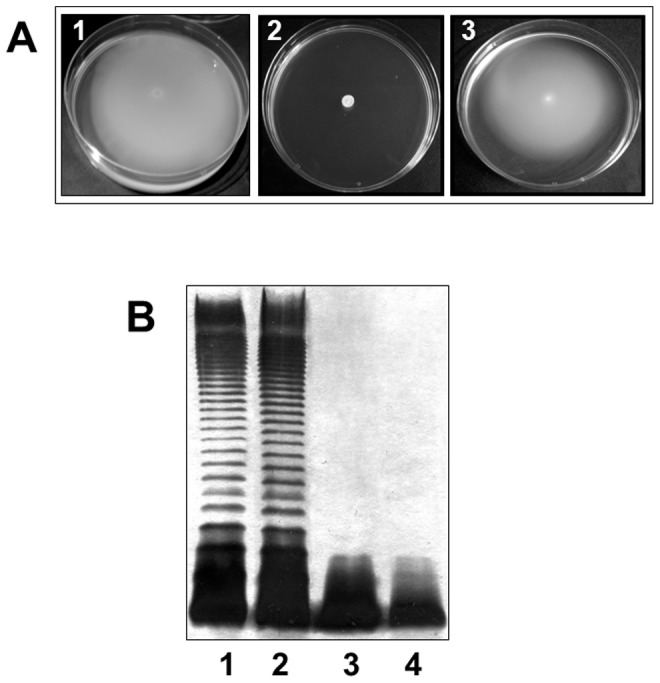
A/Motility phenotypes exhibited in swim (0.25%) agar by A. hydrophila AH-3 (1), AH-3:WecX mutant (2) and the mutant complemented with pBAD-WecX (3).B/LPS profiles of 1, A. hydrophila AH-3 (wild type); 2, AH-3:WecX mutant; 3, AH-3ΔWecP:WecX double mutant; and 4, AH-3ΔWecP:WecX with pBAD-WecX.